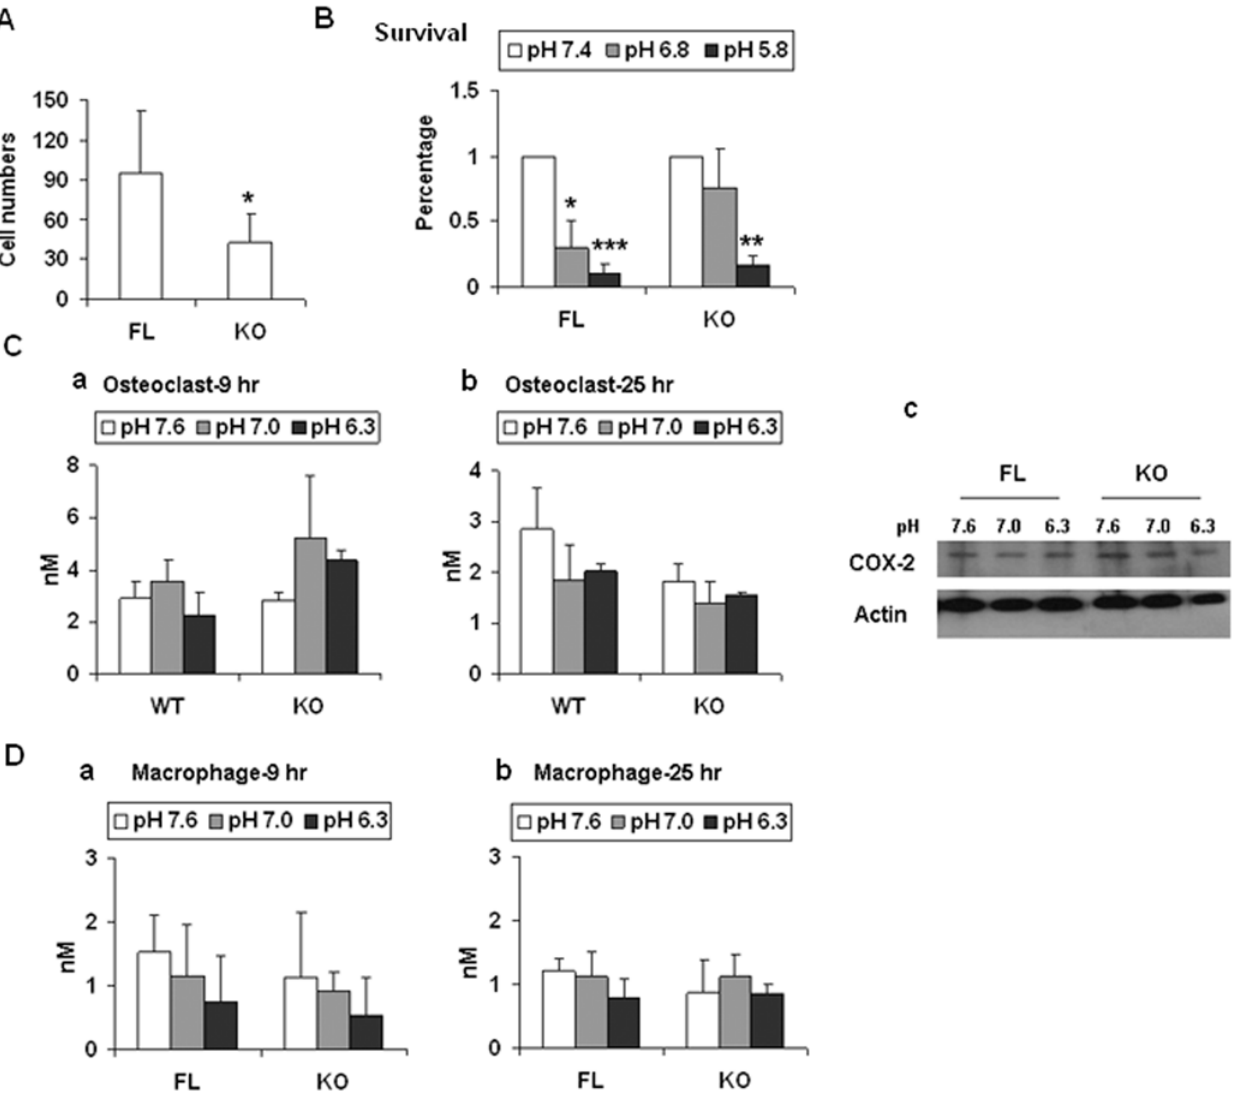
Figure9. Reduced osteoclasts differentiatedfrom bone marrowcells in OGR1 KO mice. (A) M-CSF andRANKL-inducedosteoclast numbers in OGR1 KO mice were reduced. (B) pH effects on survival of osteoclasts. Osteoclasts were cultured in medium with different pH for 20 hr. (C) Prostaglandin production and COX-2 expression in osteoclasts. Osteoclasts were cultured in different pH buffer (300 m L) in 24-well plates for indicated times and the supernatants were collected for prostaglandin analysis ( a and b ) and the cells were lysed for COX-2 expression analysis at 9 hr ( c ). The differences in different groups are not statistically significant ( P . 0.05). (D) Prostaglandin production in macrophages. The results in this figure are representative of at least 3 independent experiments. * represents a P value of , 0.05, ** represents a P value of , 0.005, and *** represents a P value of ,